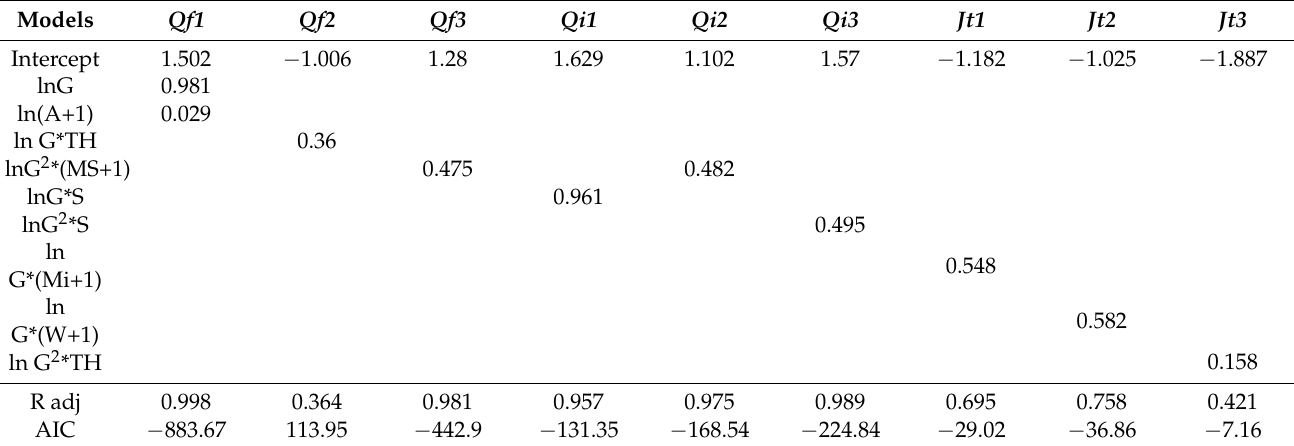
Table 5. Selected models by species for the Llano de San Marug á n site.